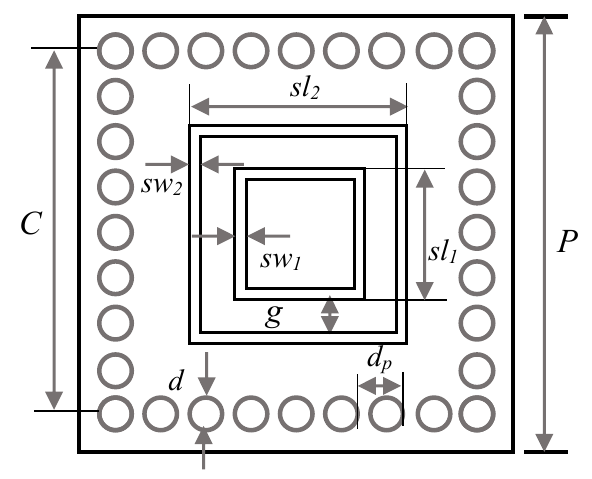
Figure 7. Dual band configuration of SIW–cavity using Double Square loop FSSs (design parameters are referred from [27]).